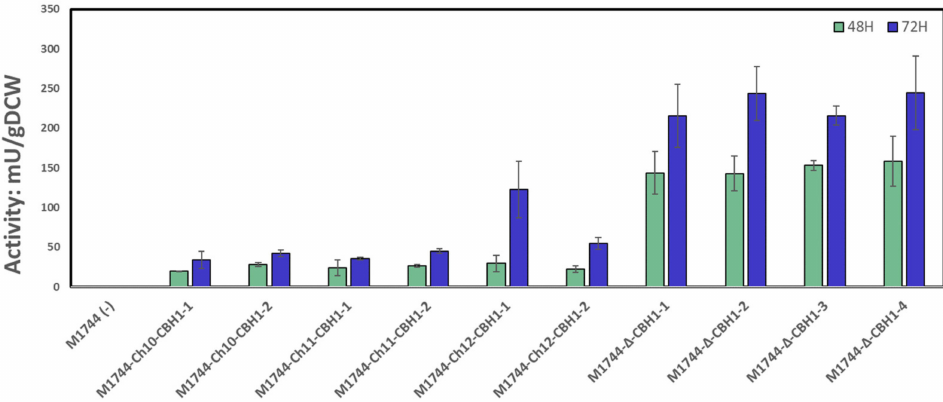
Figure 4. Cellobiohydrolase activity profile of CBH producing M1744 strains on MU-Lac after 48 and 72 h cultivations. Values obtained were normalized with the dry cell weight of each specific yeast strain. Numbers after the strain name refers to different transformants that were tested. The values given are the mean values of enzyme assays conducted in triplicates. Error bars indicate the standard deviation from the mean value for each